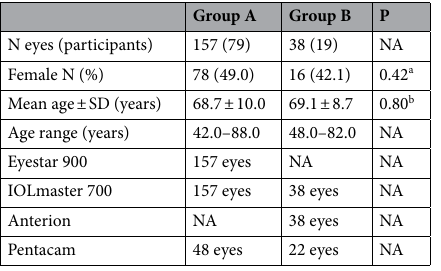
Table 1. Basic characteristics of study population. a Chi-Square. b Independent sample t-test.